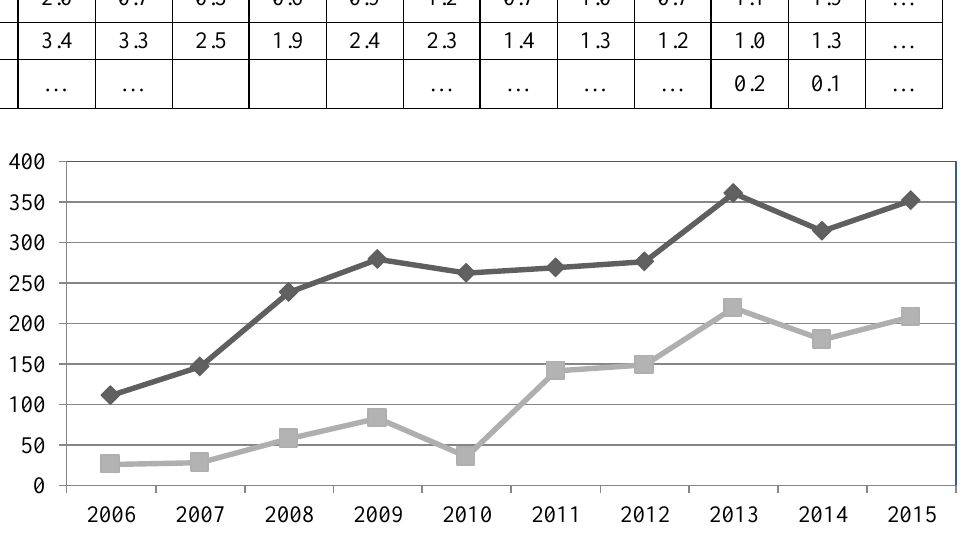
RF Consolidated budget, bln Fig. 4. Comparison of the RF consolidated budget subsidies with the federal budget for 2006–2015 in terms of the sub-section of the budget classification of expenditures "Agriculture and Fishery" in bln rubles (compiled by authors to: [15]).